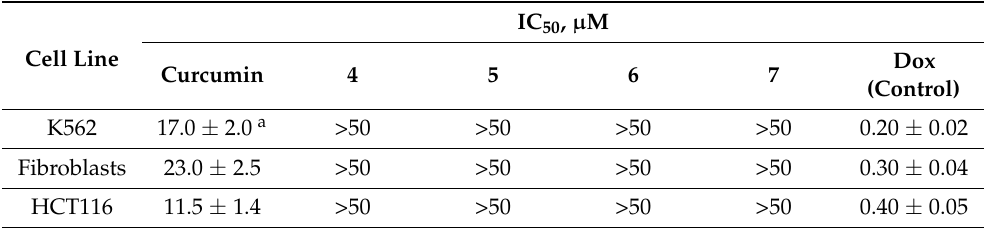
Table 1. IC 50 values for cells treated with novel cobalt-curcumin conjugates 4–7 (MTT-test results, 72 h